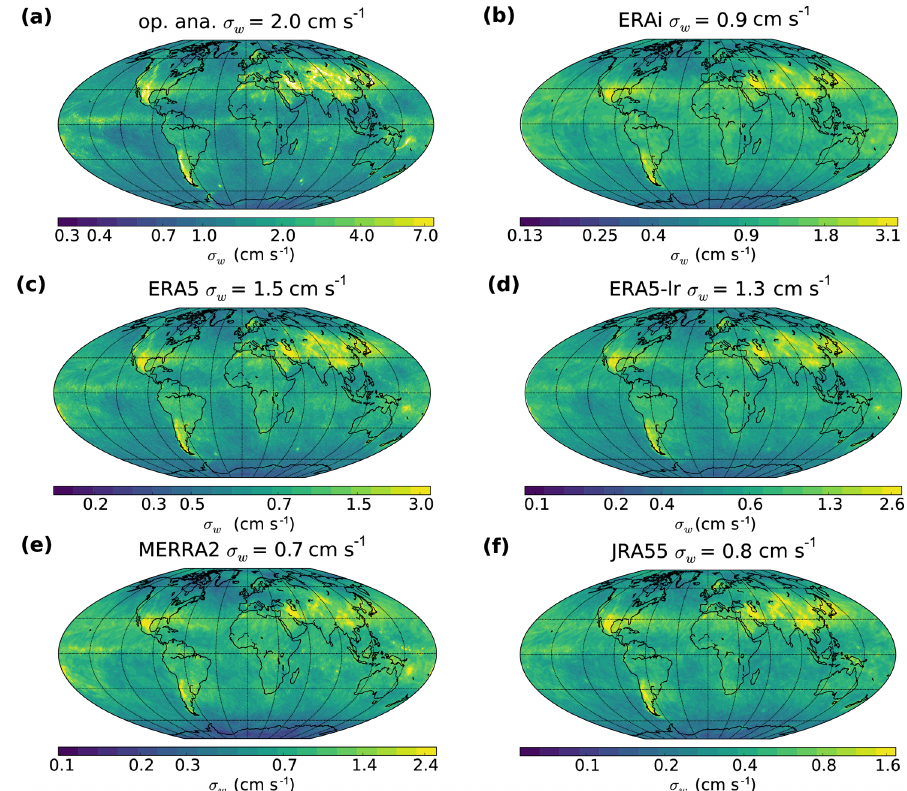
Figure 5. Global maps of vertical velocity standard deviation σ w at 100hPa in different reanalysis systems during March 2010. ERA5-lr is a retrieval from ERA5 reanalysis truncated at the same resolution as ERA-Interim (T255). Note that the color scales are logarithmic and that they have been adjusted so that the ratio between local σ w and globally averaged σ w (provided for each reanalysis in the title of the corresponding panel) corresponds to the same color in all panels. This normalization emphasizes the spatial pattern regardless of the average